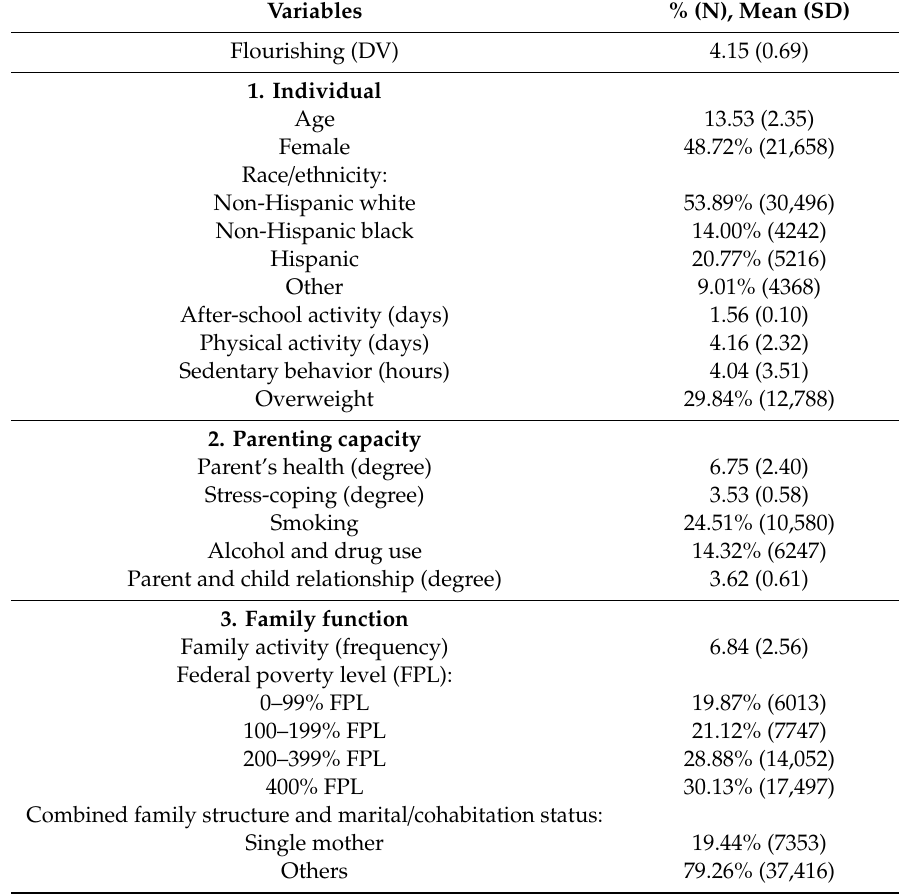
Table 1. Descriptive statistics of the study